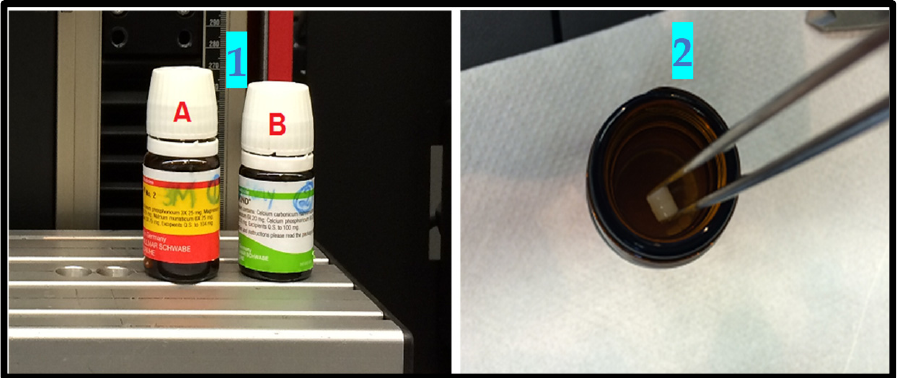
Figure 1. 1(A): Methacrylate Z350 1(B): Ceram X ( left side ). 2: The samples were stored in distilled water in a colored brown bottles ( right side ).